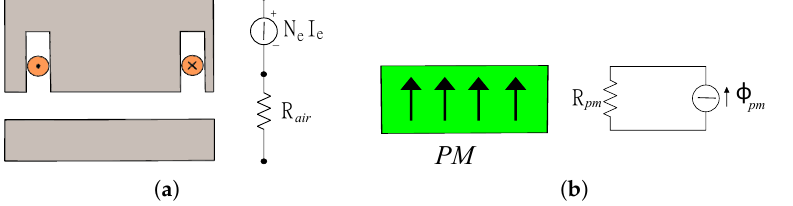
Figure 2. Elements of magnetic network. ( a ) Excitation winding and magnetic network. ( b ) PM and magnetic